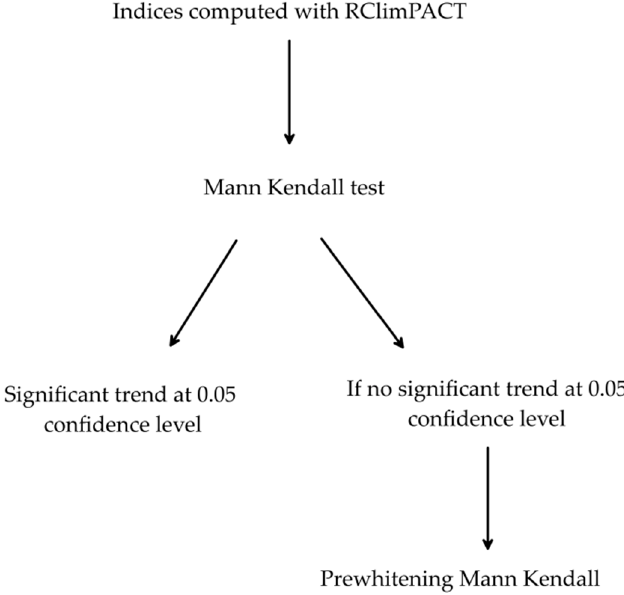
Figure 2. Trend analysis process sketch.